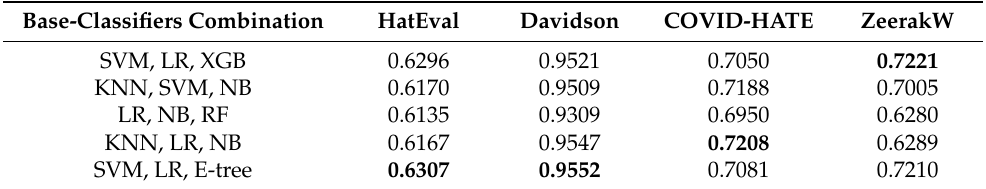
Table 9. F1-score of the majority voting ensembles using different base classifiers on test sets. Bold entries show the highest performance for each classifier on each dataset. Base-Classifiers Combination HatEval Davidson COVID-HATE ZeerakW SVM, LR, XGB 0.6296 LR, NB,